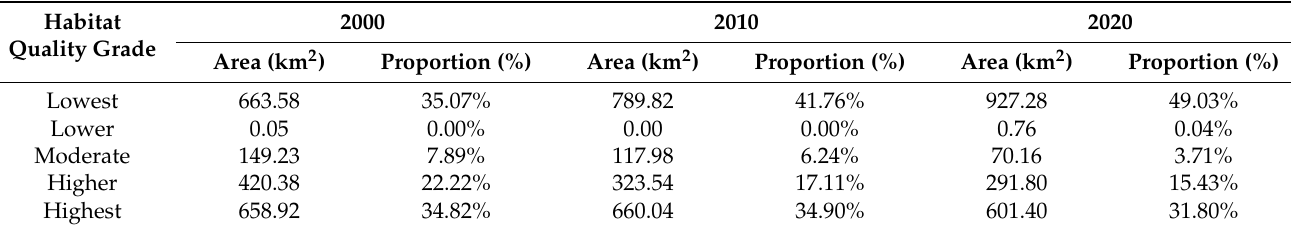
Table 5. Classification of habitat